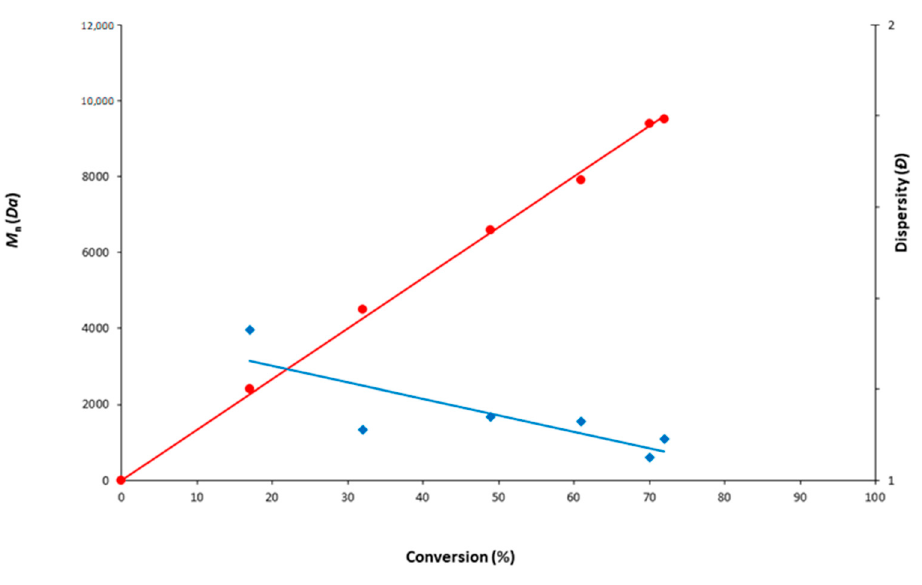
Figure 3. Plot of M n versus CHO conversion ( ● ) and M w / M n versus CHO conversion ( ♦ ) for compound 4 at 70 °C and 10 bar CO 2 .